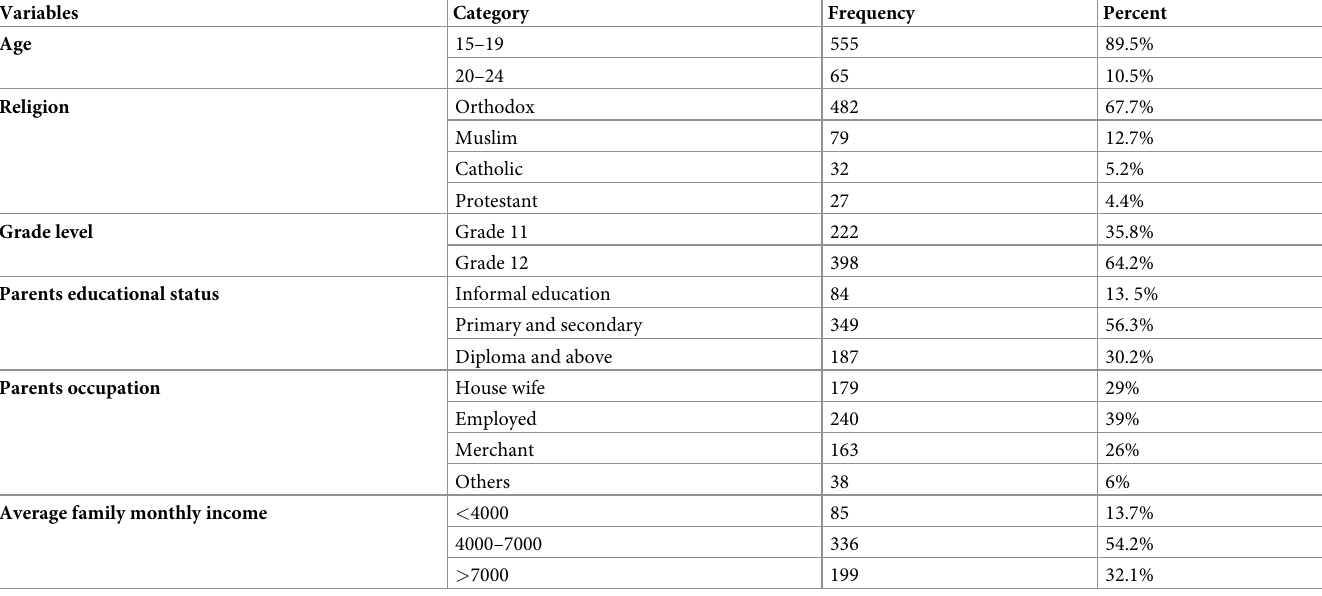
Table 1. Socio-demographic characteristics of female preparatory school students in Bahir Dar city, Ethiopia, 2021(n = 620).